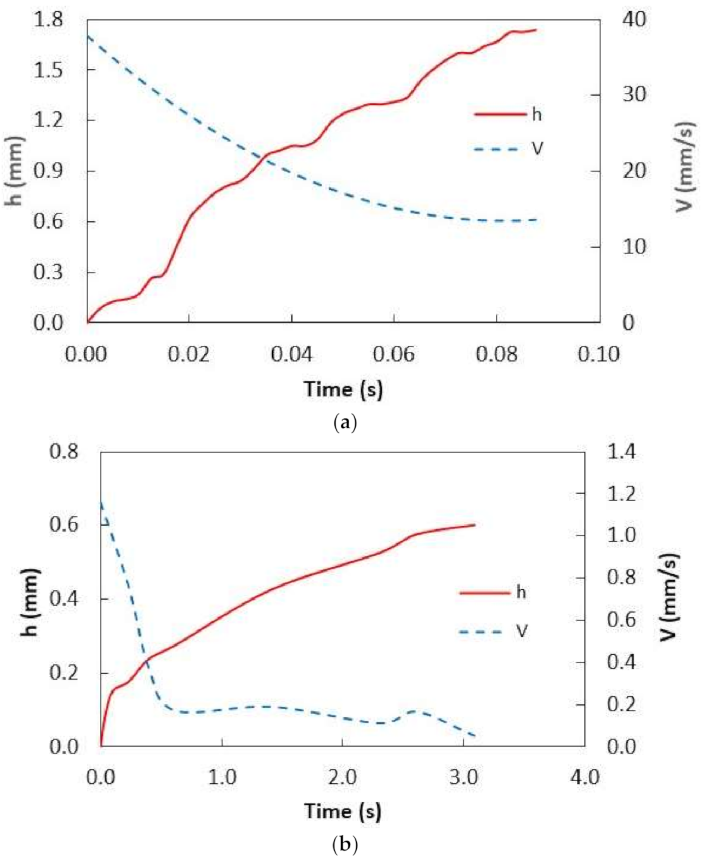
Figure 6. Infusion height and infusion velocity with time: ( a ) water, and ( b ) silicon oil. h represents infusion height on dust surface and V is the infusion